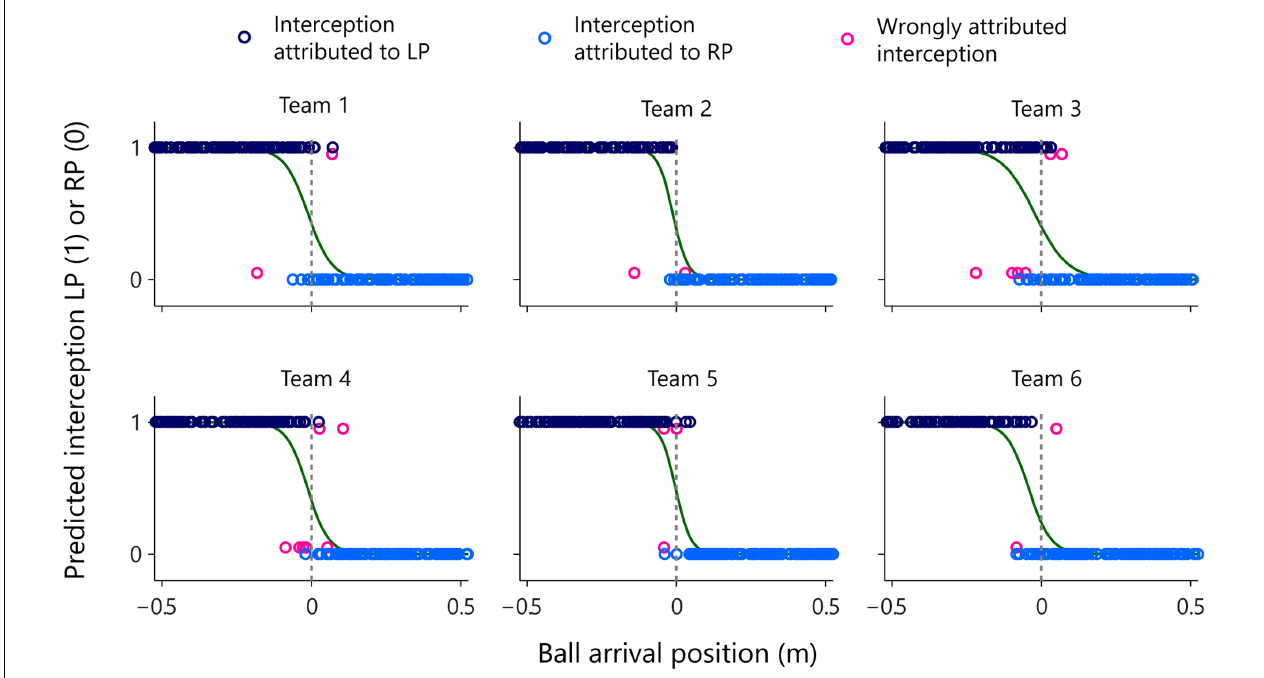
FIGURE 9 | Graphical summary of predicted interception performance as a function of ball arrival position for all six teams separately. The participant that would intercept the ball was predicted as being the participant who first reached positive AV. Ball arrival positions for correctly attributed interceptions are indicated by dark blue (LP interception) and light blue (RP interception) circles. Ball arrival positions of incorrectly attributed interceptions are indicated by pink circles with a slight vertical offset. The green curves depict the logistic curves representing the probability that LP ( P = 1) or RP ( P = 0) will intercept the ball as a function of ball arrival position. The horizontal dashed gray lines at ball arrival position 0 cm indicate the center of the interception axis.